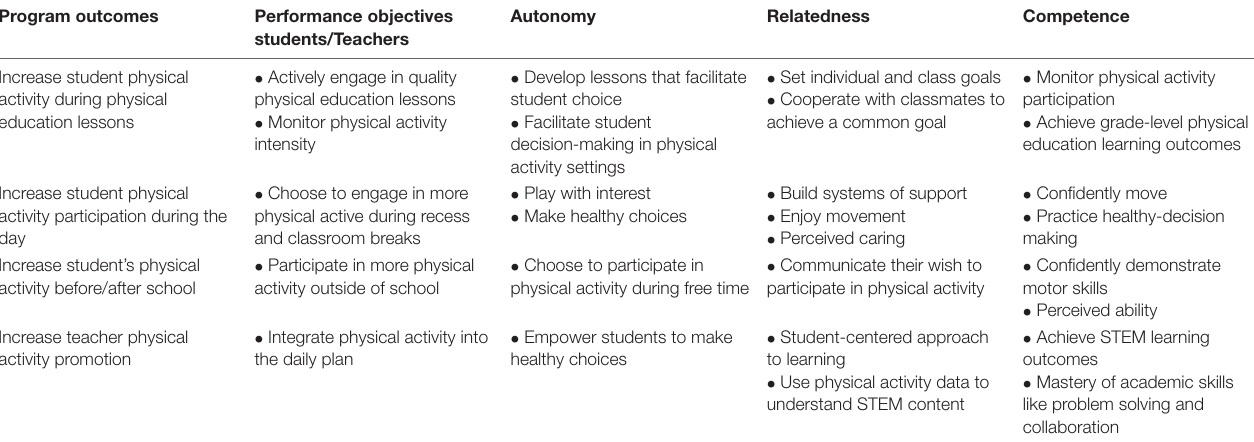
FIGURE 3 | Visual of how to self-report physical activity intensity. TABLE 2 | Example of CSPAP component, performance objectives, and SDT constructs. Program